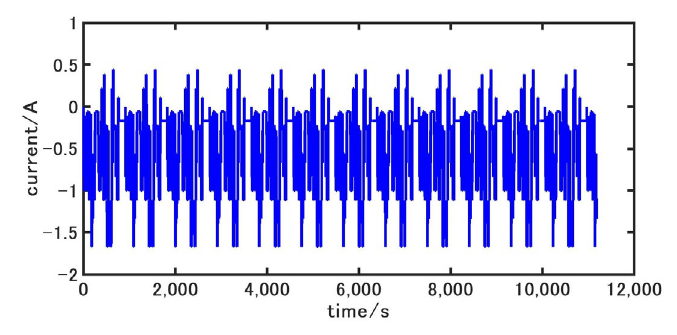
Figure 9. Current of BJDST Driving Condition.